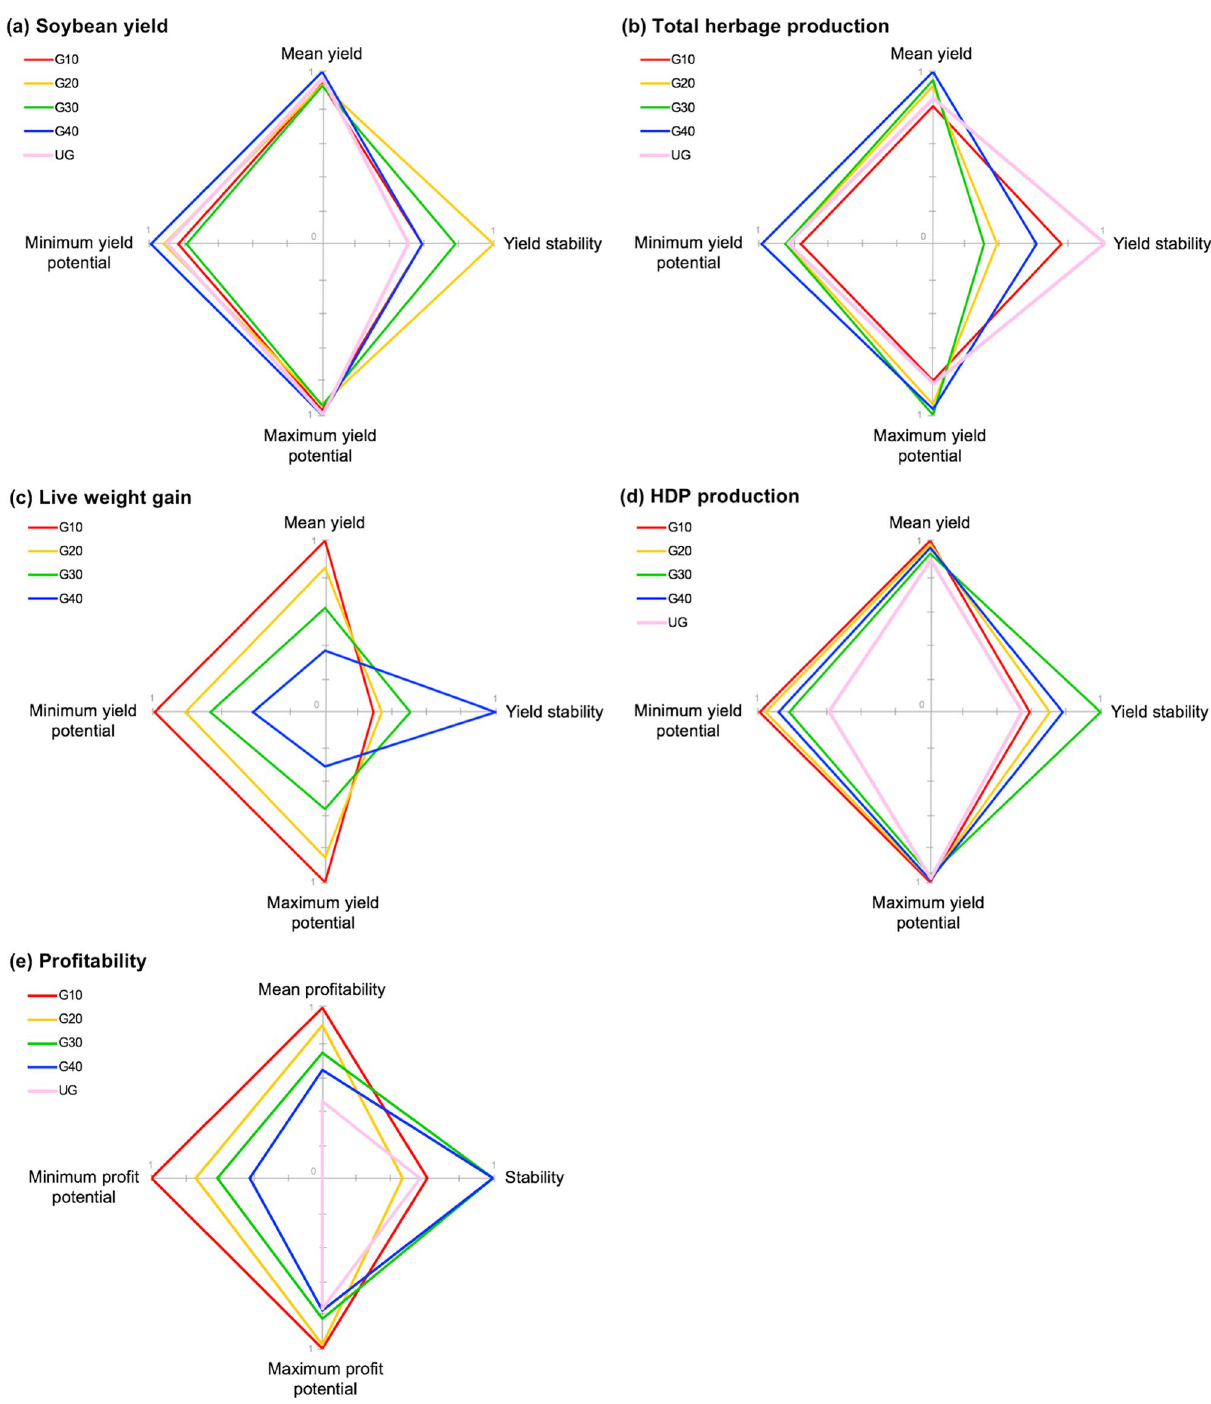
Figure 3. Tradeoffs between performance and stability of ( a ) soybean yield (kg grain ha −1 ), ( b ) total herbage production (kg dry matter ha −1 ), ( c ) animal live weight (LW) gain (kg LW ha −1 ), ( d ) human-digestible protein (HDP) production (kg HDP ha −1 ) and ( e ) profitability (USD ha −1 ) of soybean systems integrated with different levels of cattle grazing during the winter period in southern Brazil. Values represent standardized ratio to the maximum value for each metric. Yield stability is the average rank of four stability metrics (Table